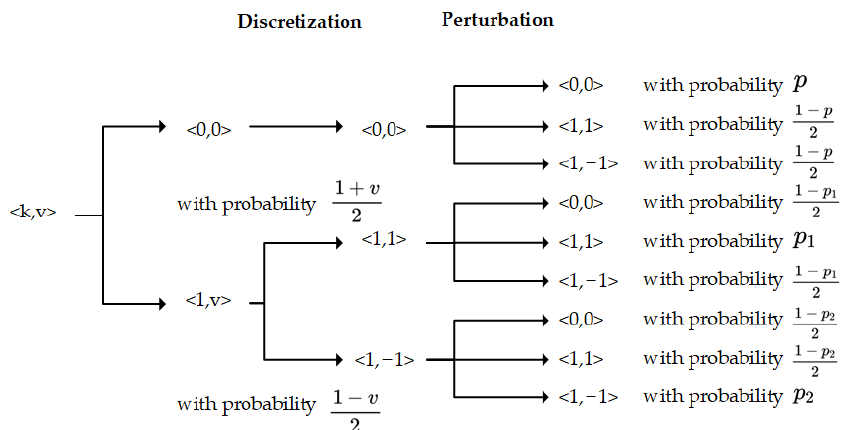
Figure 4. Local perturbation of MDLDP ‐ LRR.